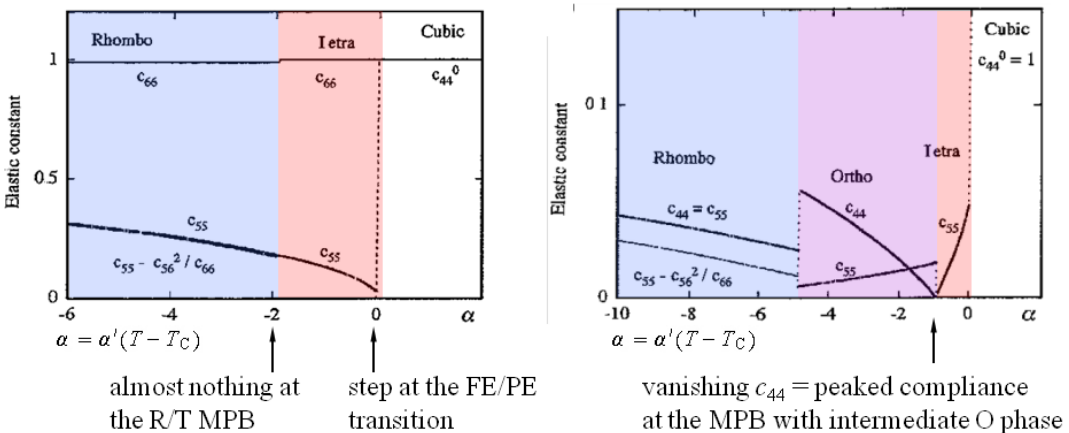
Figure 7. Elastic anomalies at C/T/O/R transitions, using a Landau expansion up to the 6th order in P with two sets of coefficients: one reproducing a direct R/T transition and one with the intermediate O phase (adapted from [57] (1999) The Japan Society of Applied